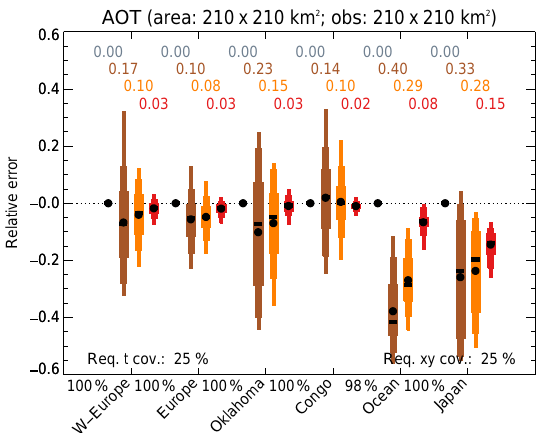
Figure 16. Monthly representation errors for an imager on a geosta- tionary satellite after collocation: purely spatial sampling (grey), no collocation (brown), area data collocated to the day of observations (bright orange) and area data collocated to the hour (red). Further explanation in Sect.